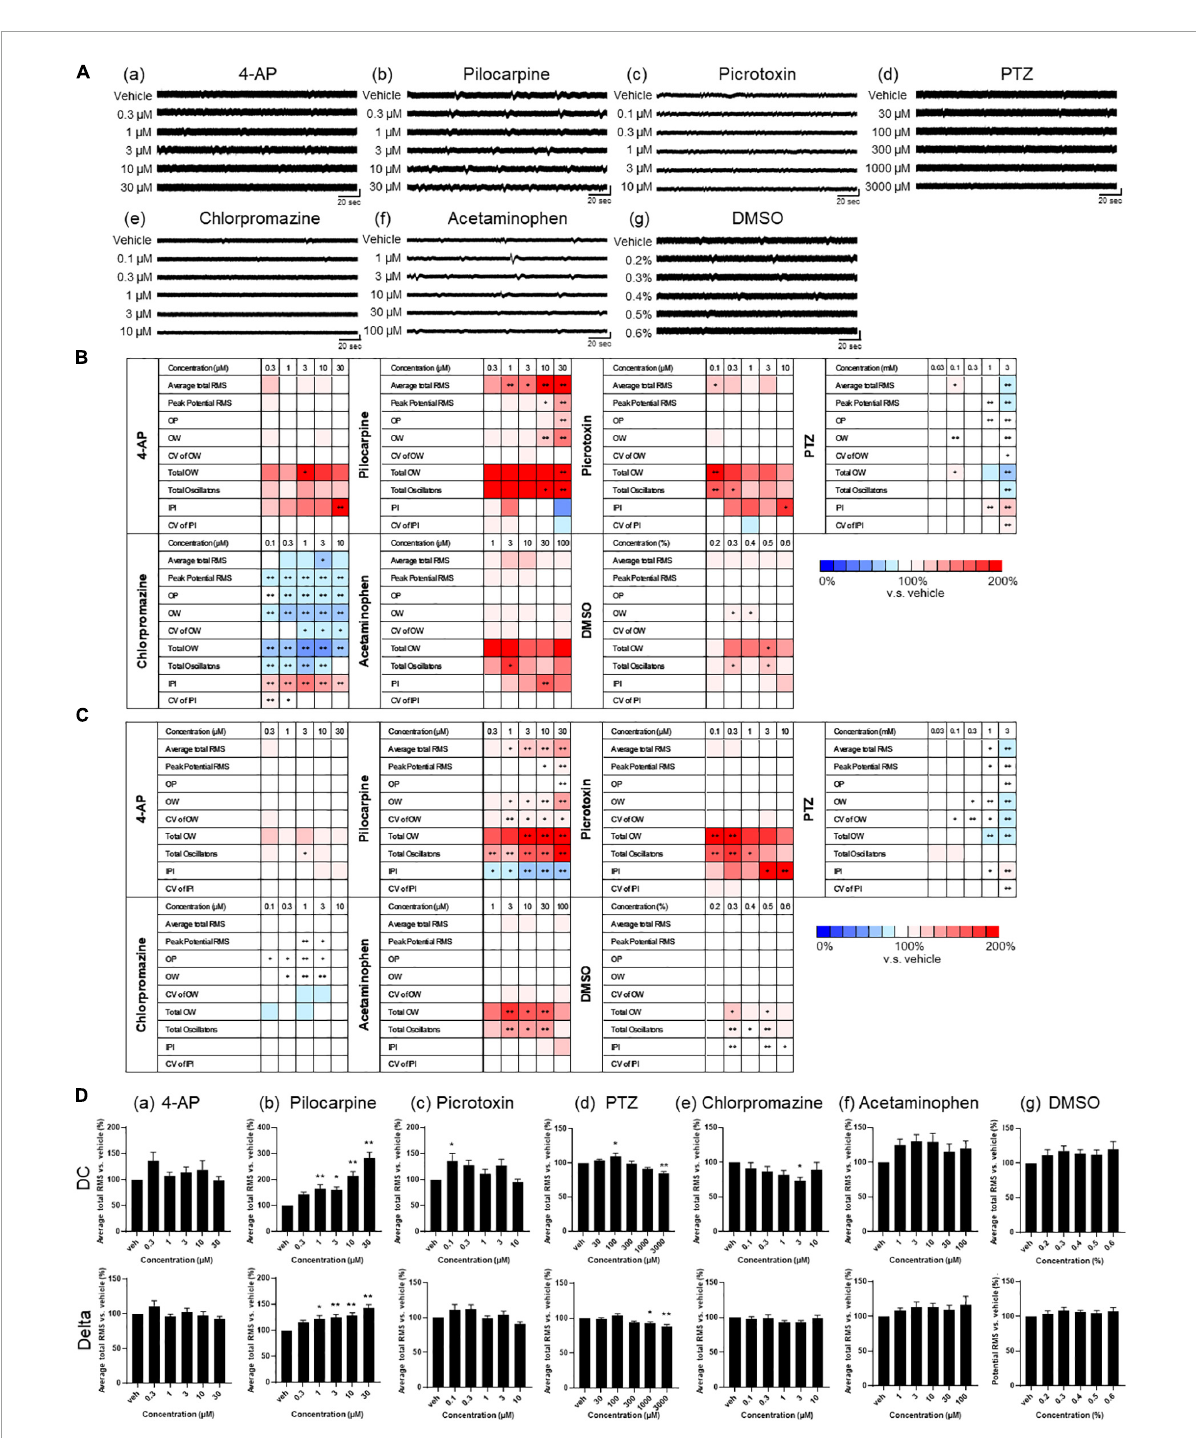
FIGURE4 Drug responses of primary astrocytes detected by MEA. (A) Representative oscillation waveform after the cumulative administration of seizurogenic compounds (a) 4-AP, (b) pilocarpine, (c) picrotoxin, (d) PTZ, and (e) chlorpromazine, and neutral compounds (f) acetaminophen and (g) DMSO. Compounds were added to astrocytes during 1–3 weeks of the culture. Vertical scale bar, 40 µ V; horizontal scale bar, 20 ms. (B,C) Heatmaps of the analytical parameters of seizurogenic compounds and neutral compounds in DC potential (B) and in delta band (C) . 4-AP ( n = 6), pilocarpine ( n = 6), picrotoxin ( n = 6), PTZ ( n = 6), chlorpromazine ( n = 6), acetaminophen ( n = 6), and DMSO ( n = 6). (D) Dose-dependent changes of average total RMS in DC potential (upper) and in delta band (lower). One-way ANOVA followed by Dunnett’s test, * p < 0.05, ** p < 0.01 versus vehicle. Error bar,